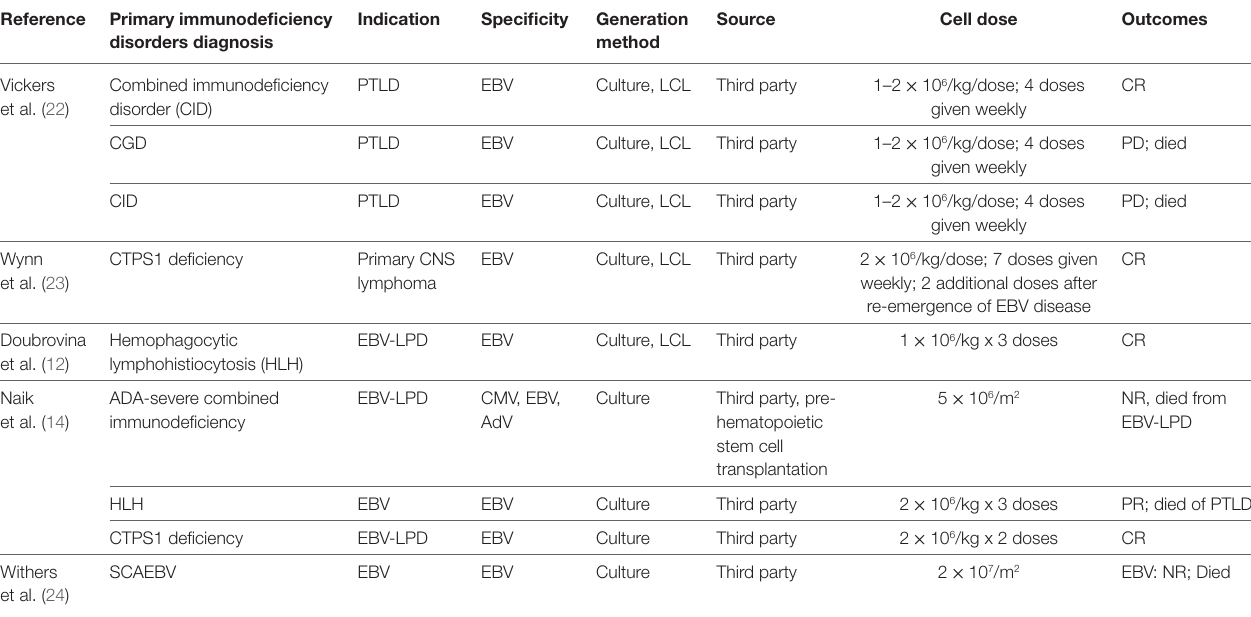
TABLe 2 | Previous clinical use of third party Epstein–Barr Virus (EBV)-specific T